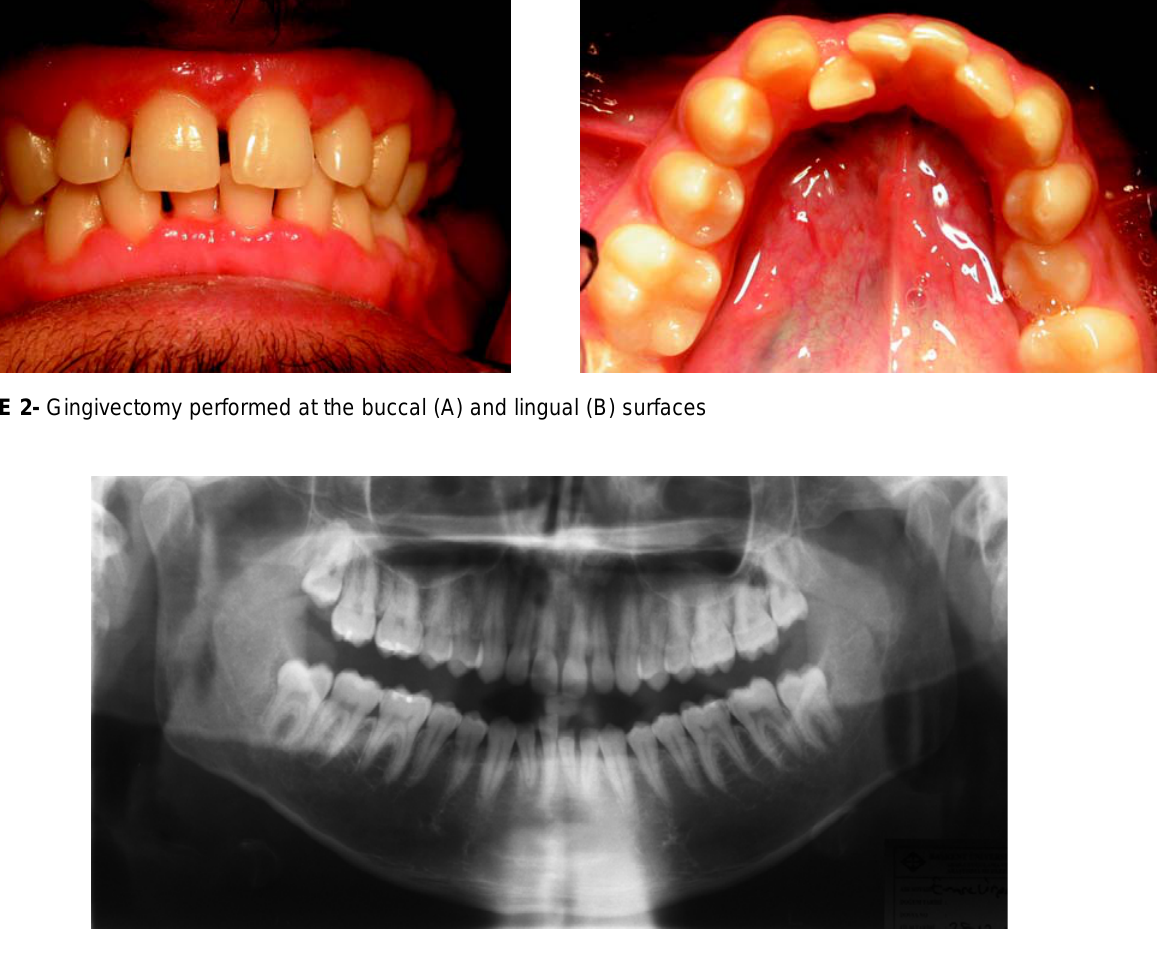
FIGURE 3- Migration of anterior teeth due to excessive and fibrous gingival enlargement, though without alveolar bone